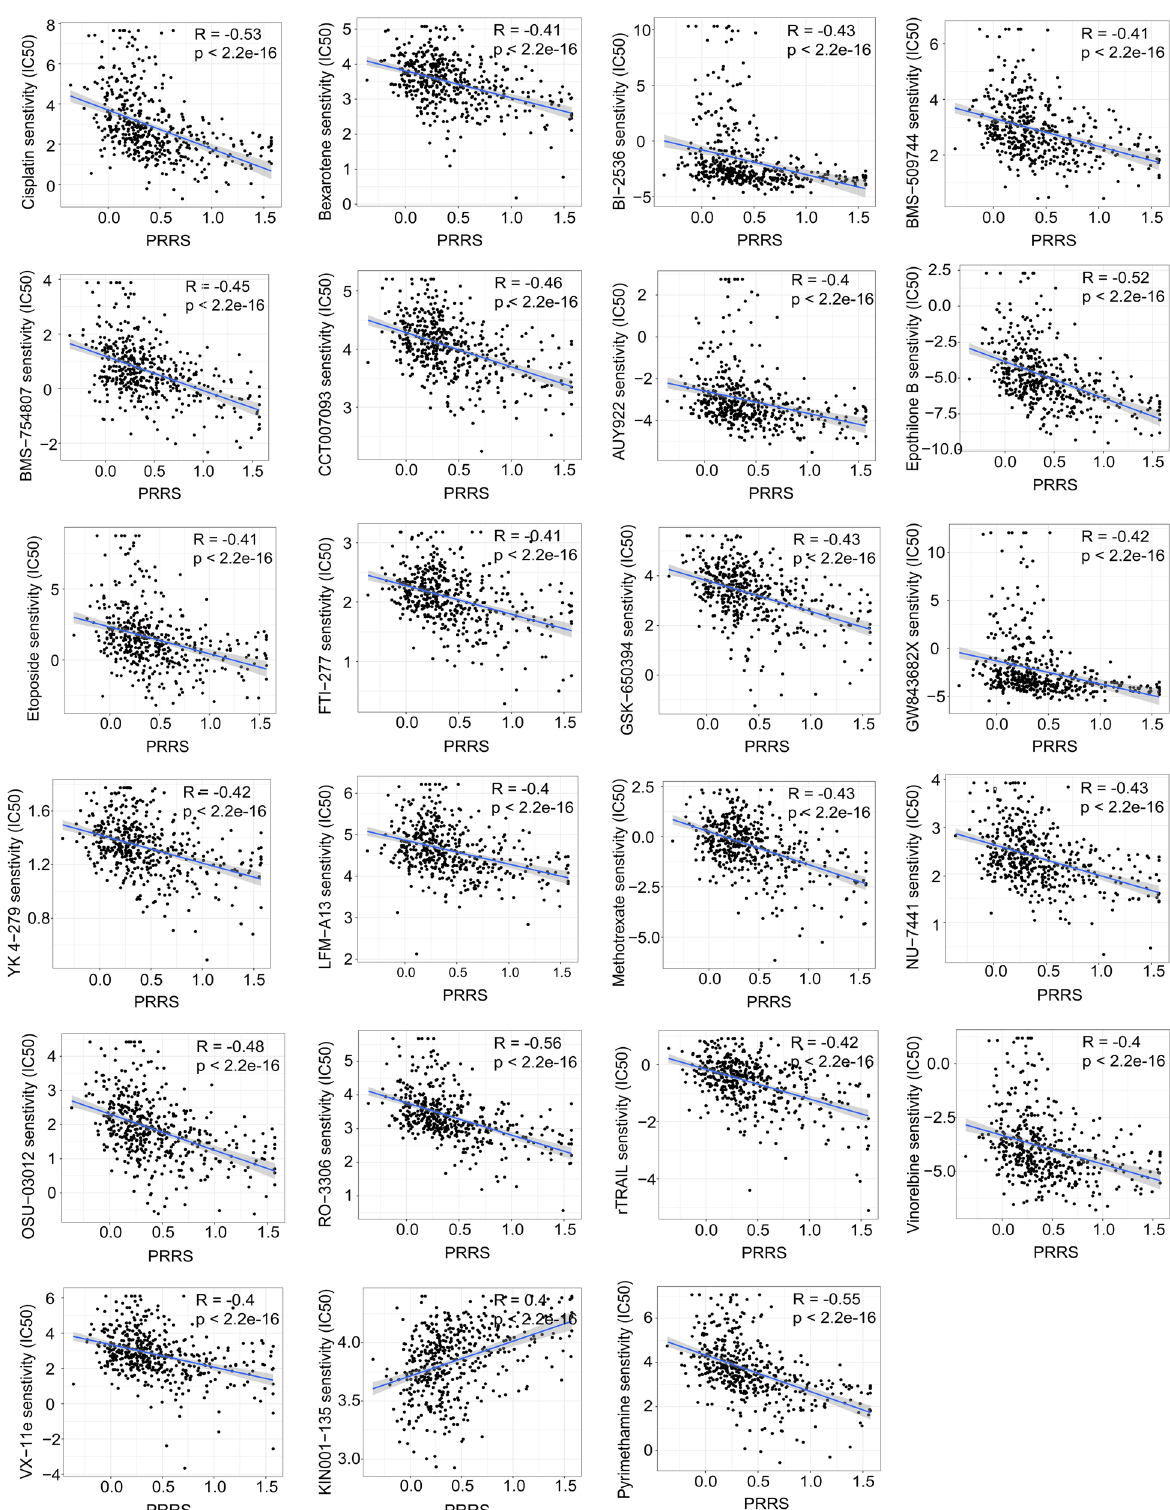
Figure 8: Screening of potential drugs for LUAD patients. Correlation analysis between the sensitivity of 23 drugs and